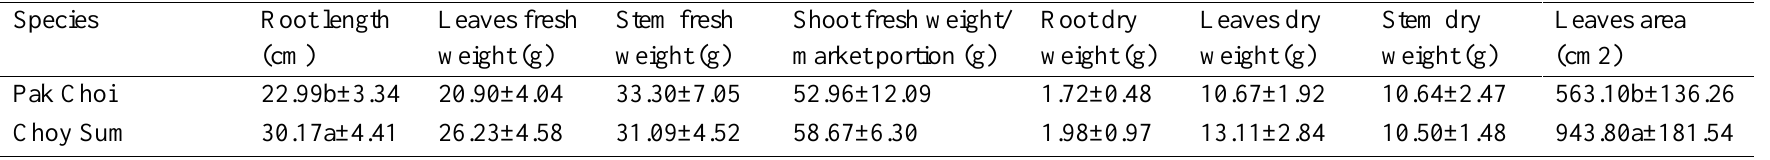
Table 11. Effect of 2 species of brassica on root length, leaves fresh weight, stem fresh weight, shoot fresh weight (market portion), root dry weight, leaves dry